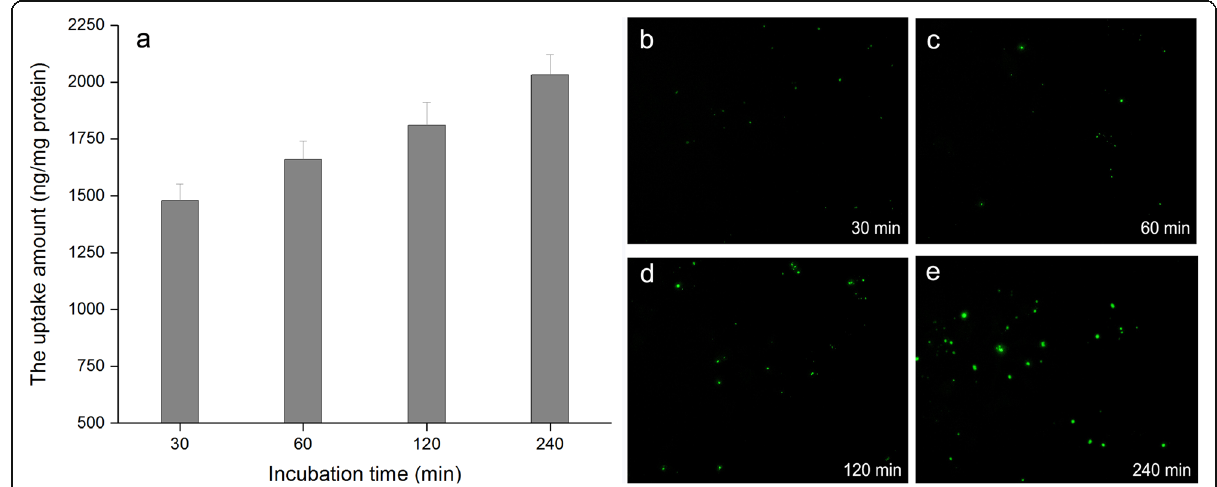
Fig. 12 In vitro cellular uptake of GA-loaded liposomes by Hep G2 cells. a The uptake amount versus incubation time. b – e Fluorescence microscopy images at 30, 60, 120, and 240